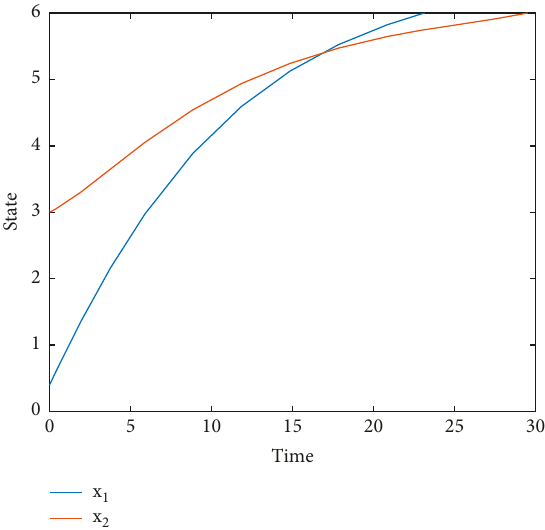
Figure 4: The state of (41) without impulse.